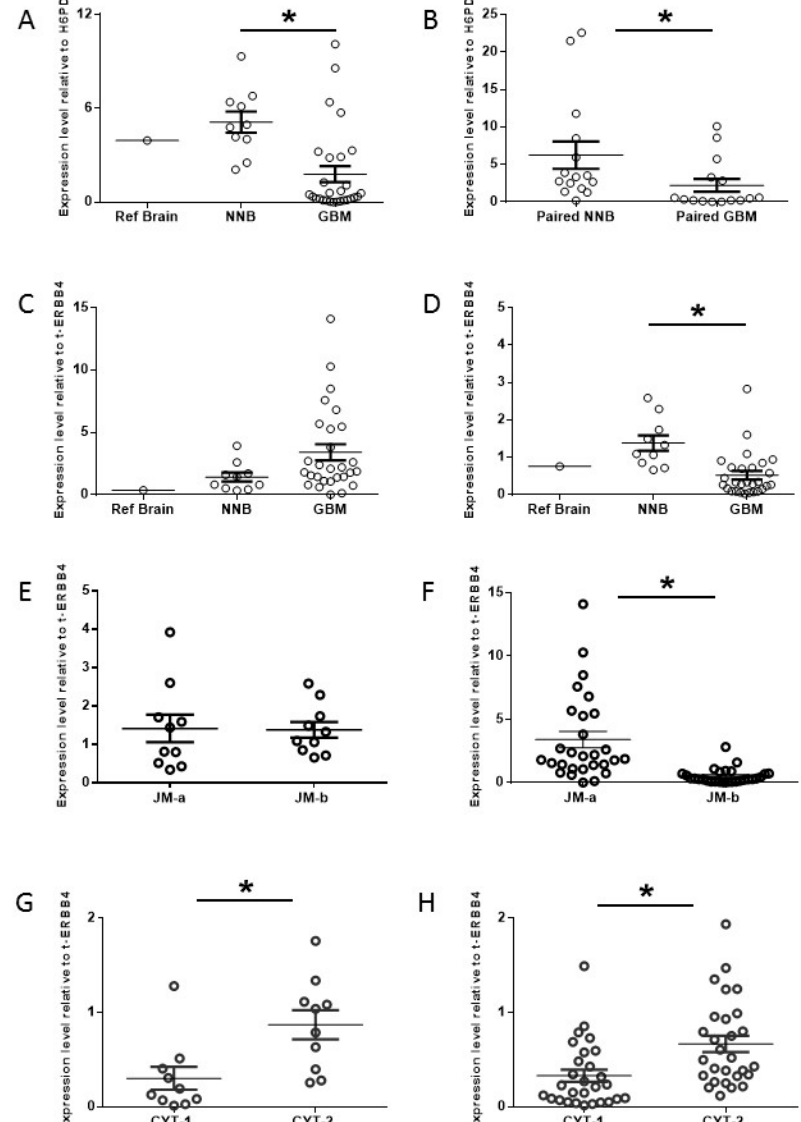
Figure 2. Total ERBB4 and ERBB4 variant expression. ERBB4 expression in 10 non-neoplastic normal brain (NNB), 28 glioblastoma (GBM), and 15 paired NNB and GBM samples. Expression levels were determined by RT-qPCR; total ERBB4 levels were standardized to H6PD mRNA, and variant levels were standardized to total ERBB4 mRNA levels. All measurements were made simultaneously but are displayed separately to aid comparison. Reference brain (Ref Brain) was a pooled brain sample from 7 donors (Ambion, Thermo-Fisher, Waltham, MA, USA) used for comparison. Total ERBB4 mRNA expression in Ref Brain, NNB and GBM samples ( A ). Total ERBB4 mRNA expression in paired NNB and GBM samples ( B ). Expression of JM-a ( C ) and JM-b ( D ) variants of ERBB4 in Ref Brain, NNB and GBM samples. Comparison of JM-a and JM-b expression levels in NNB ( E ) and GBM ( F ). (Note that the data shown in ( E , F ) are rescaled from ( C ) and ( D ).) CYT-1 and CYT-2 expression levels in NNB ( G